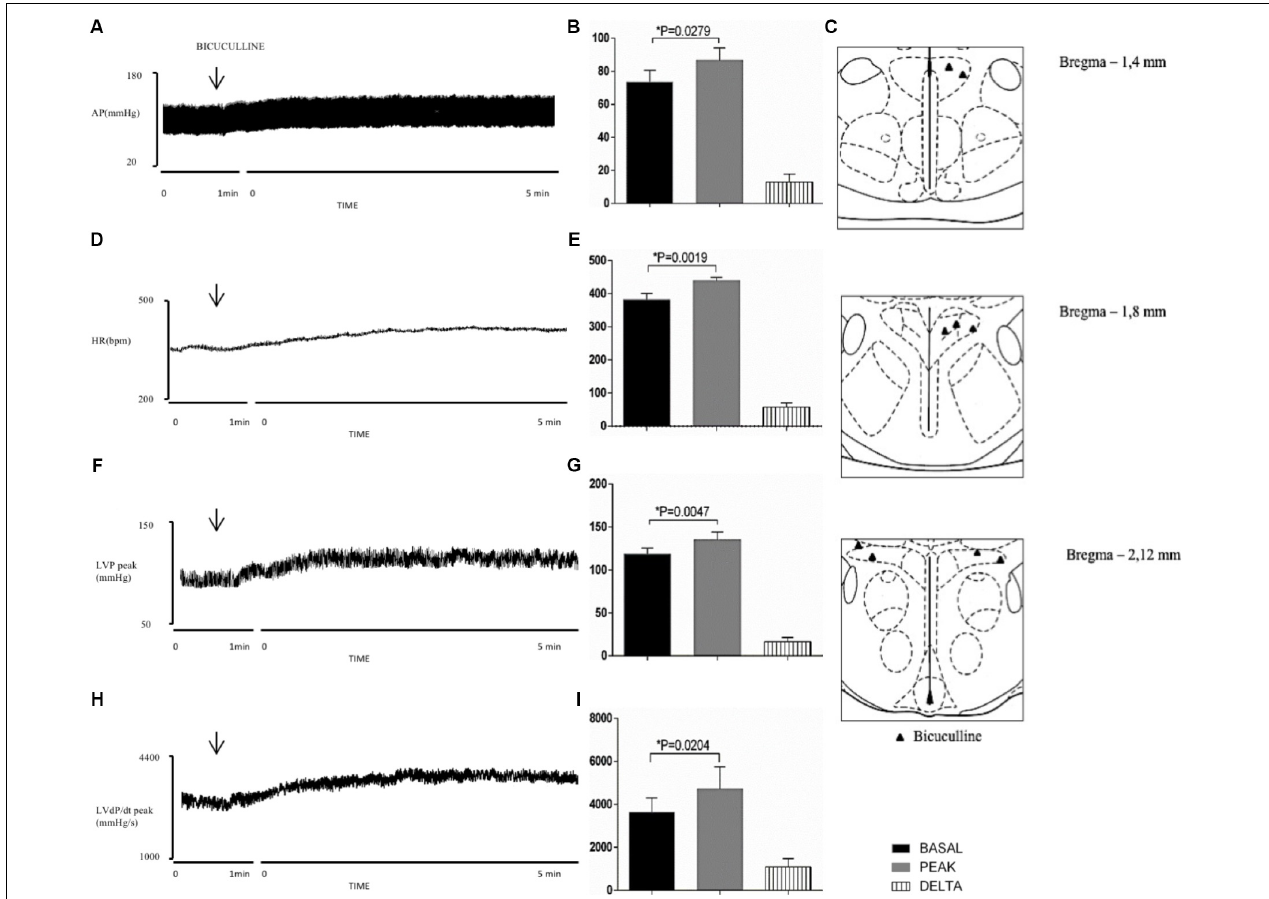
FIGURE 3 | Left column – Chart records illustrating the responses of MAP (A) , HR (D) , LVP peak (F) and LVdP/dt peak (H) produced by the unilateral microinjection of bicuculline in PVN (arrows indicate the moment of injection). Middle column – Mean maximal changes in MAP (B) , HR (E) , LVP peak (G) , and LVdP/dt peak (I) in response to unilateral microinjections of bicuculline (100 nl). Values refer to the means collected in the basal period (2 min before the central injection), and at the maximum point of response to microinjection and its variation. ∗ P < 0.05. MAP, mean arterial pressure; HR, heart rate; LVP peak, maximum pressure in the left ventricle; LVdP/dt peak, first derivative of cardiac left ventricle pressure. Right column – Schematic representation of the injection sites stained by Evans blue dye from group injected with bicuculline (100 nl) into PVN (C) . n =